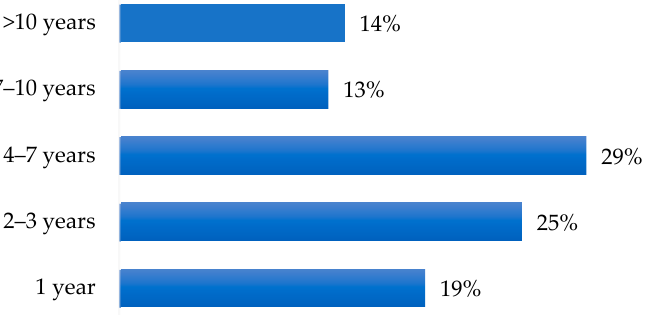
Figure 1. Diagnosis of DME (years after diagnosis of diabetes). Both eyes were generally affected (71% of cases). In 18% of cases, only the left eye was affected and in 11% of cases, only the right eye was affected.